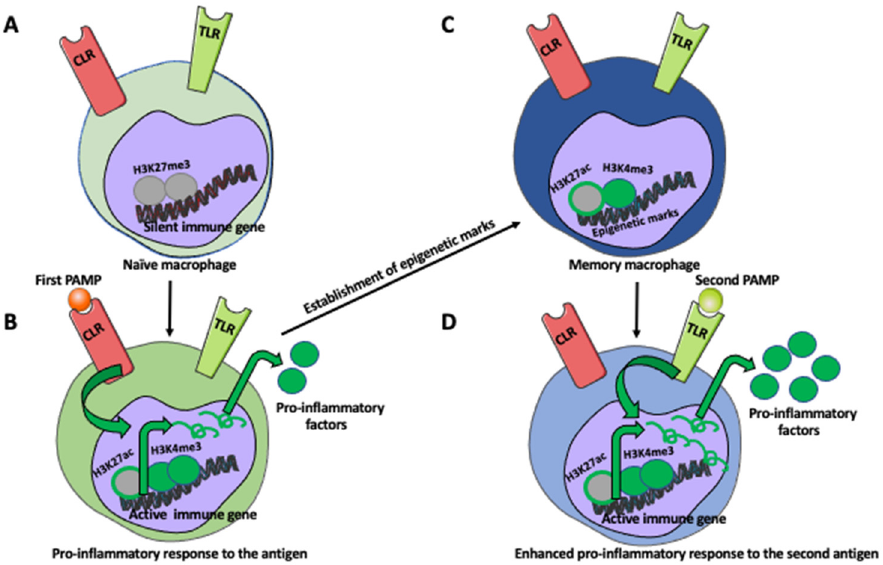
Figure 1. Development of memory macrophage.( A ) Naïve (unstimulated) macrophage expresses